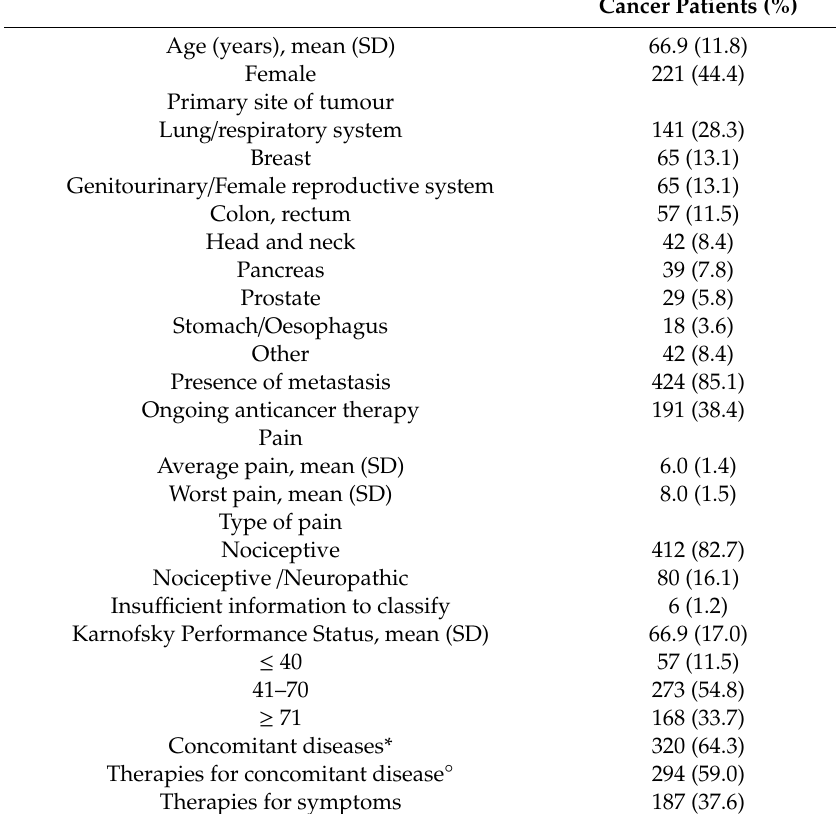
Table 1. Demographics and main clinical characteristics of 498 cancer patients at